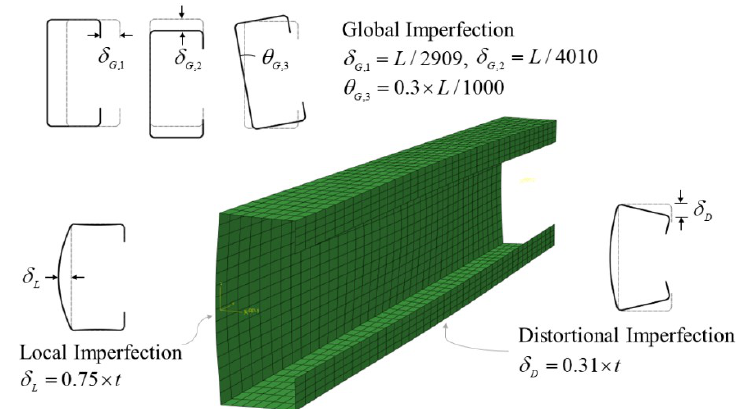
Figure 2. Details of FE model.